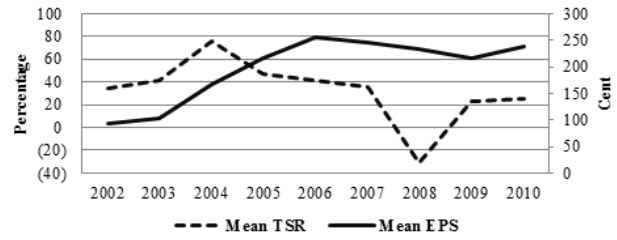
Figure 3: Mean EPS (cent per share) and TSR (%) values